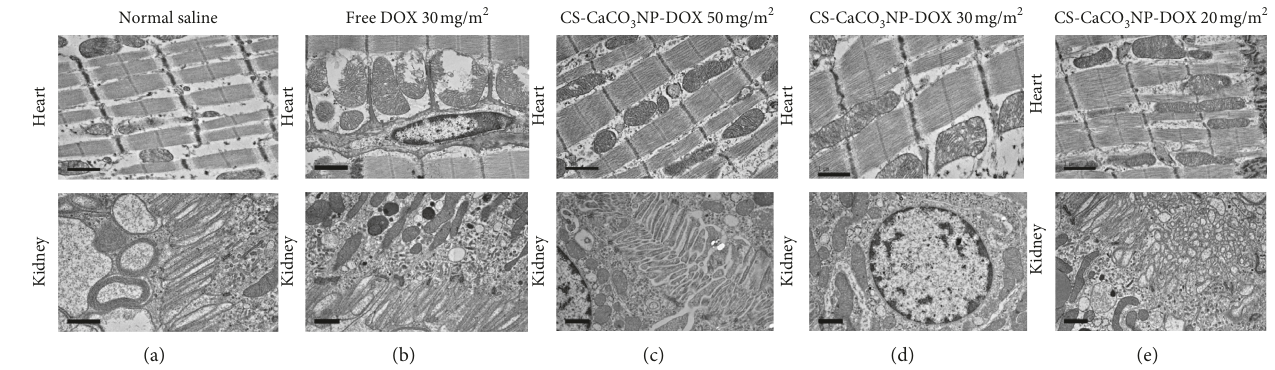
Figure 11: Electron micrograph (TEM) of the left ventricular myocardial tissue section and kidney section. (a) Myocardial tissue section of dogs given normal saline showing clear distinct cisternae on the mitochondria, with spindle-shaped nucleus within the myofilament and the proximal convoluted tubules of the dogs given normal saline revealing its lumen and apical cellular membrane with microvilli appearing normal with distinct mitochondrial cisternae and nerves surrounded by myelin sheaths. (b) Free DOX 150mg/m 2 showing extensive mitochondrial damage and rupture with marked swelling and cristae disorientation, scattered vacuolated cardiomyocyte, with free empty vacuum and Z -band aggregate in close cluster to ribosome in the cytoplasm with the dilated proximal convoluted tubules with vesicle and distorted cristae in the mitochondria. (c) CS-CaCO 3 NP-DOX 250mg/m 2 showing mitochondrial rupture with cristae disorientation with free empty vacuum with few dilated proximal convoluted tubules and shrinked apical microvilli and vesicle and sarcoplasmic tubules. (d) CS-CaCO 3 NP-DOX 150mg/m 2 showing clear distinct cisternae on the mitochondria, with sarcoplasmic tubules, myofilament with the renal nucleus with distinct peripheral distribution of chromatic material and normal appearance with mild swollen mitochondrial and rough endoplasmic reticulum with a normal basement membrane thickness. (e) CS-CaCO 3 NP-DOX 100mg/m 2 showing clear distinct cisternae on the mitochondria, with sarcoplasmic tubules, myofilament with the normal appearance of renal tissue with mild swollen mitochondrial and rough endoplasmic reticulum with a normal basement membrane thickness (1 µ